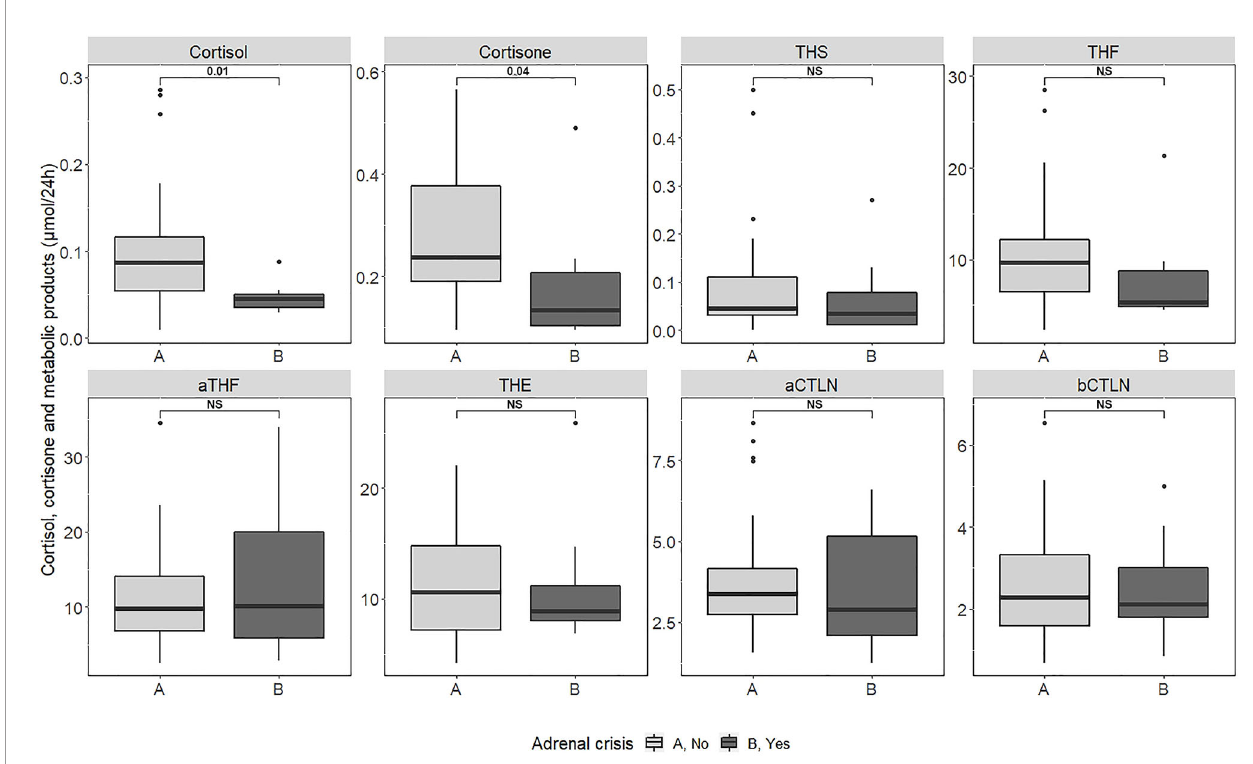
FIGURE 1 | Cortisol and cortisone and metabolic products excretion in 24h urine collections in patients with and without a past history of adrenal crisis. NS, not signi fi